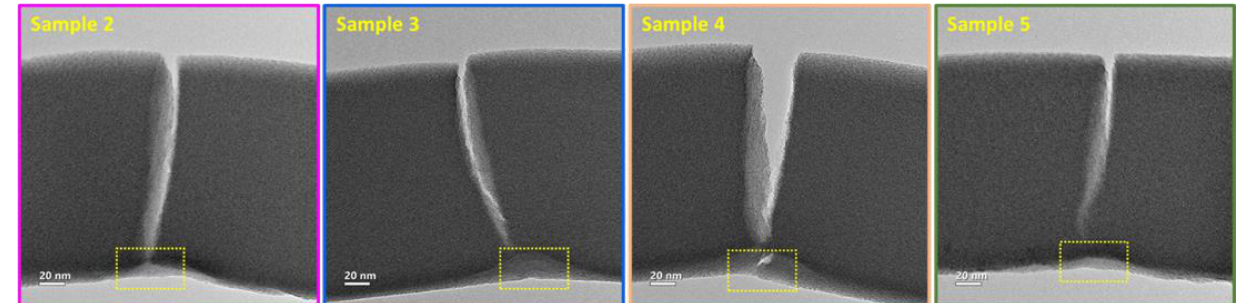
Figure 6. TEM images of fractured beams, after the in situ bending test. Bright field, 200 kV, objective aperture 60 µ m. The post-fracture images show the trajectory of the crack propagation and indentation marks (highlighted by dashed yellow squares) caused by the sharp wedge of 50 nm tip radius.